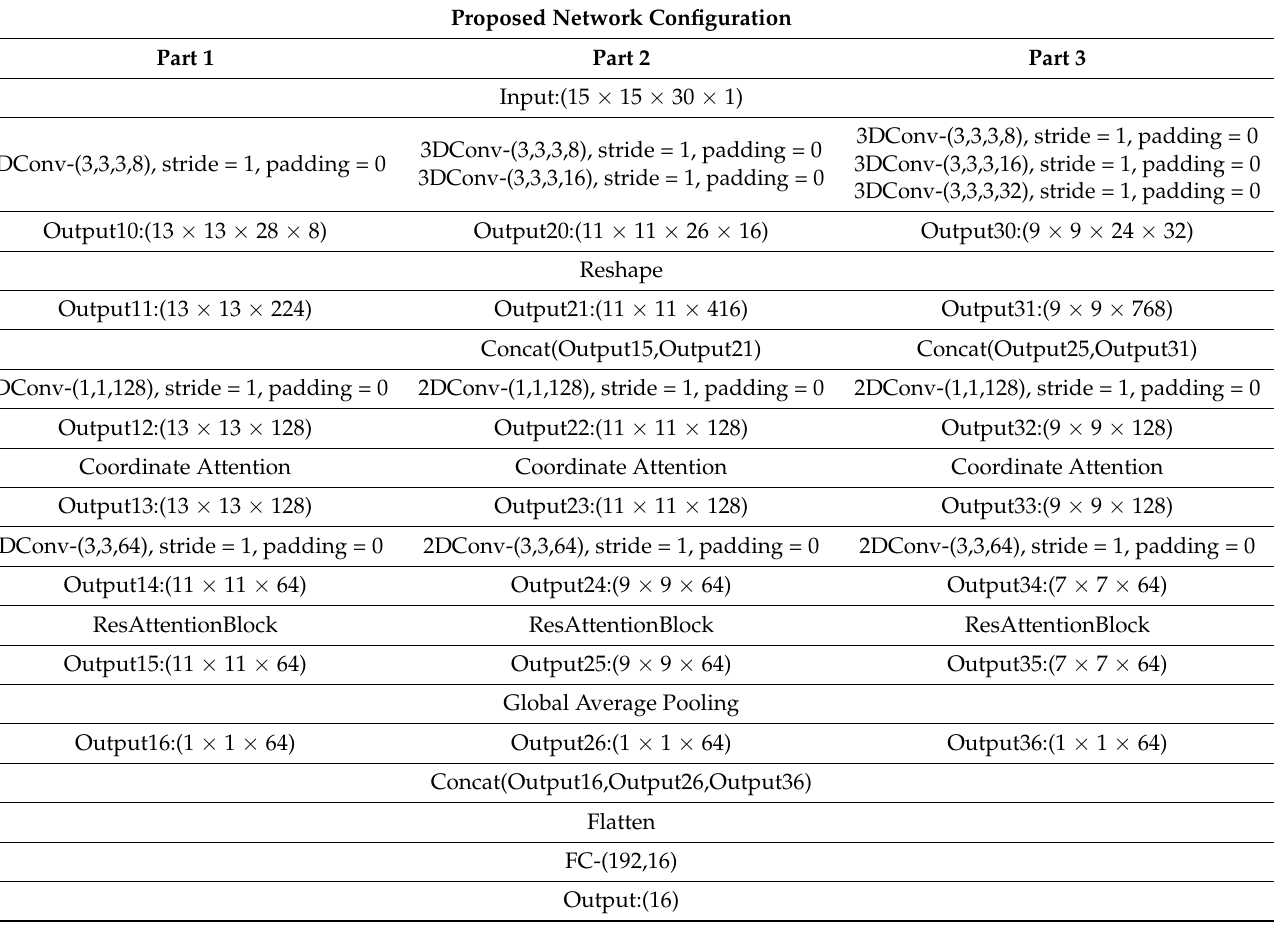
Table 4. The network configuration for the proposed model on the IP